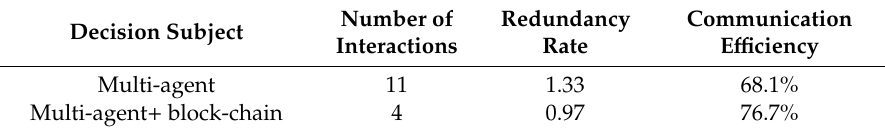
Table 3. Comparison of indicators after introducing dual-ring mobile